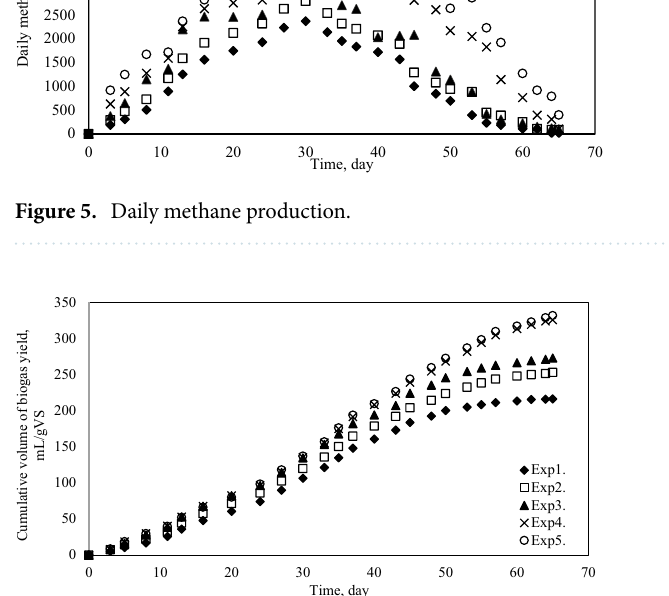
Figure 6. Cumulative biogas production